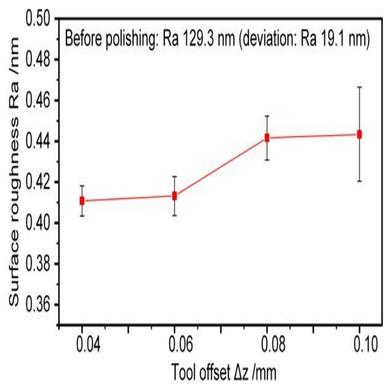
Measured average surface roughness versus tool offset.